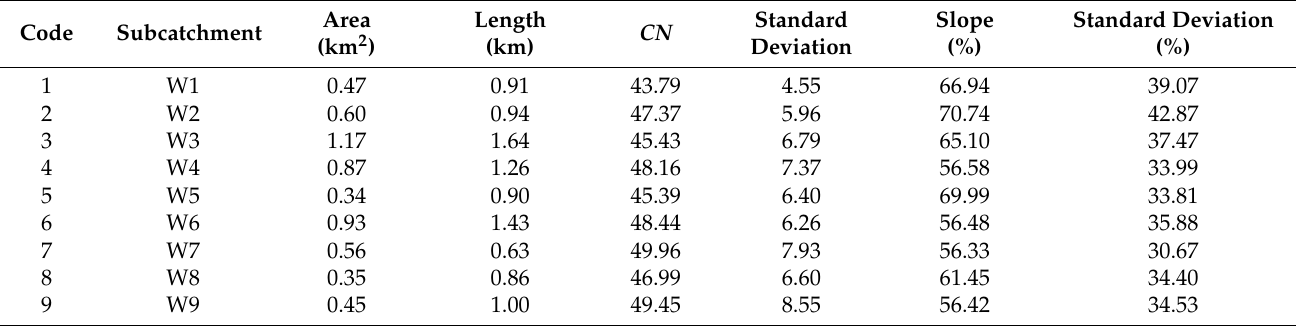
Figure 5. Values of CN in the WMG catchment under the condition of AMCI (drought). Table 3. Values of CN and slope in the